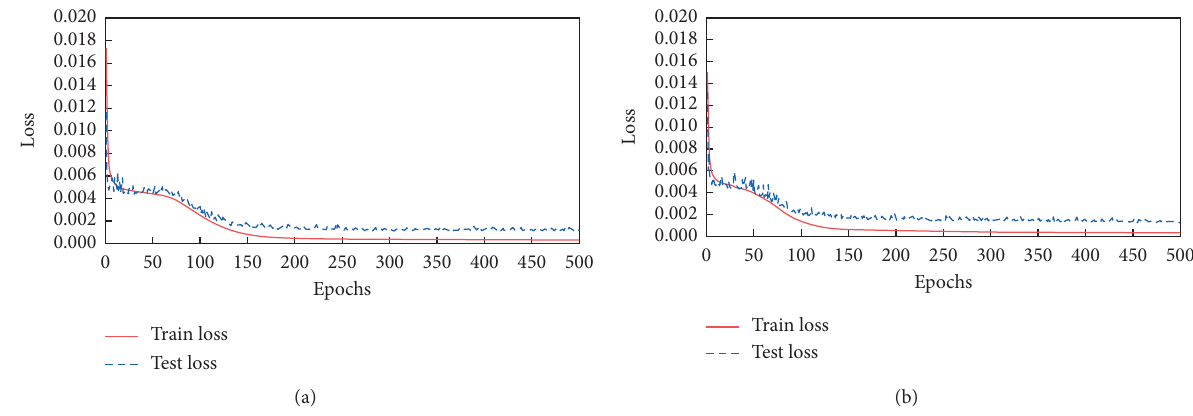
Figure 5: Loss function curves of the training set and test set: (a) CNN-LSTM-attention; (b) CNN-GRU-attention.